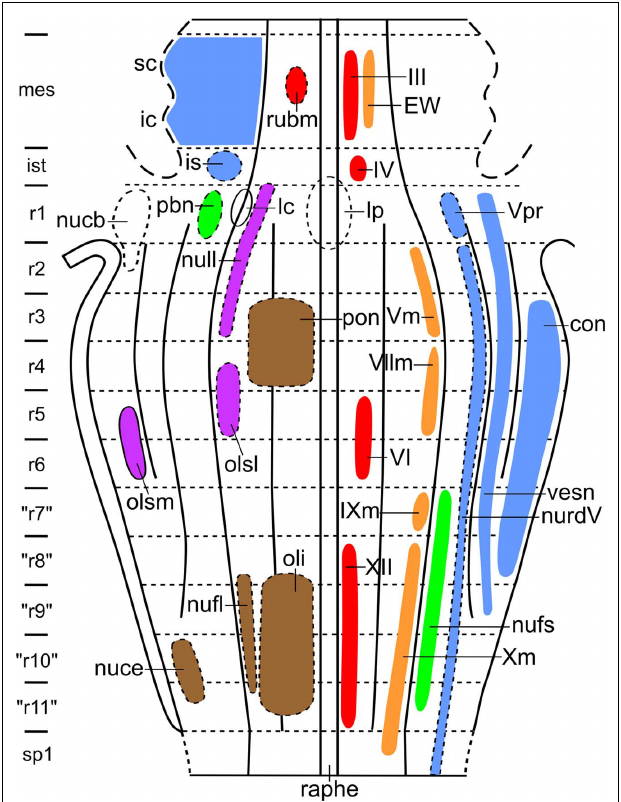
FIGURE 10 | Provisional topological chart of the brainstem of amniotes, showing the zonal and segmental allocation of cell masses, as determined by Puelles and collaborators. In order to avoid crowding, primary sensory and primary motor nuclei are shown to the right, whereas centers of higher order are shown to the left.